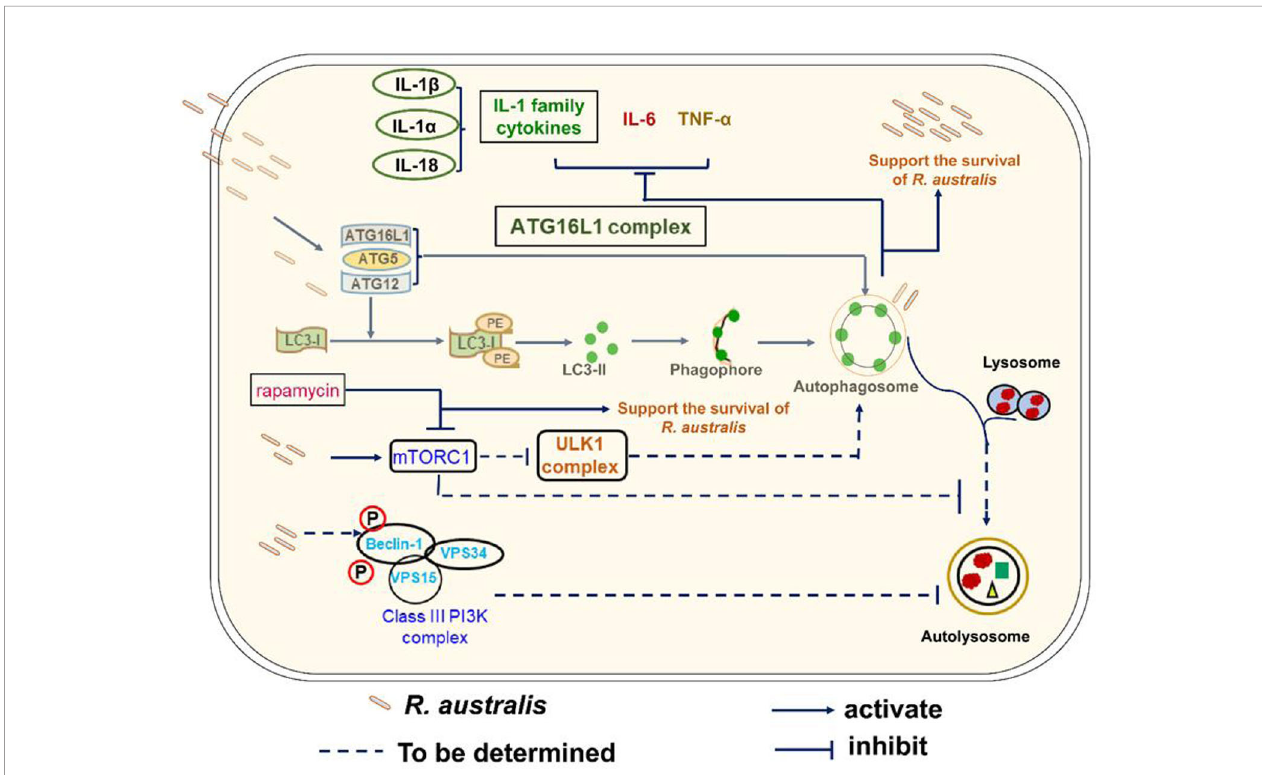
FIGURE 8 | Schematic diagram of interactions of Atg5 -dependent autophagy and mTORC1 with R. australis in macrophages. This schematic diagram depicts the molecular mechanisms involved in the modulation of autophagy and activation of mTORC1 by R. australis in order to bene fi t bacterial infection. R. australis activates the ATG5-ATG12-ATG16L1 complex leading to accumulation of LC3 (+) autophagosomes. Atg5 (+) LC3 (+) autophagosomes induced by R. australis in macrophages inhibit production levels of IL-1 family cytokines including IL-1 b , IL-1 a and IL-18 as well as other in fl ammatory cytokines such as IL-6 and TNF- a , the effects of which favor rickettsial infection. R. australis activates mTORC1 signaling at 1 h p.i. in macrophages when the Atg5 -dependent autophagic response is induced. Thus, R. australis -induced autophagic response is resistant to regulation by mTORC1 signaling. It would be interesting to explore whether R. australis - induced autophagosomes can fuse with lysosome and mature into autolysosomes, and how ULK and class III PI3K complex are involved in this process in the future. Solid lines represent pathways demonstrated in our current and previous studies, while dashed lines refer to the mechanisms hypothesized but not